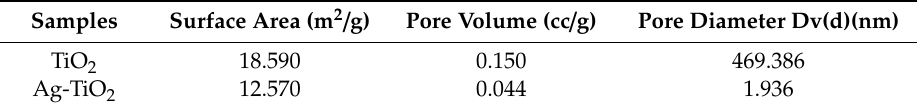
Figure 4. Adsorption isotherms and pore size distributions of di ff erent TiO 2 : ( a ) TiO 2 , and ( b ) Ag-TiO 2. Table 2. BET data of TiO 2 and Ag-TiO